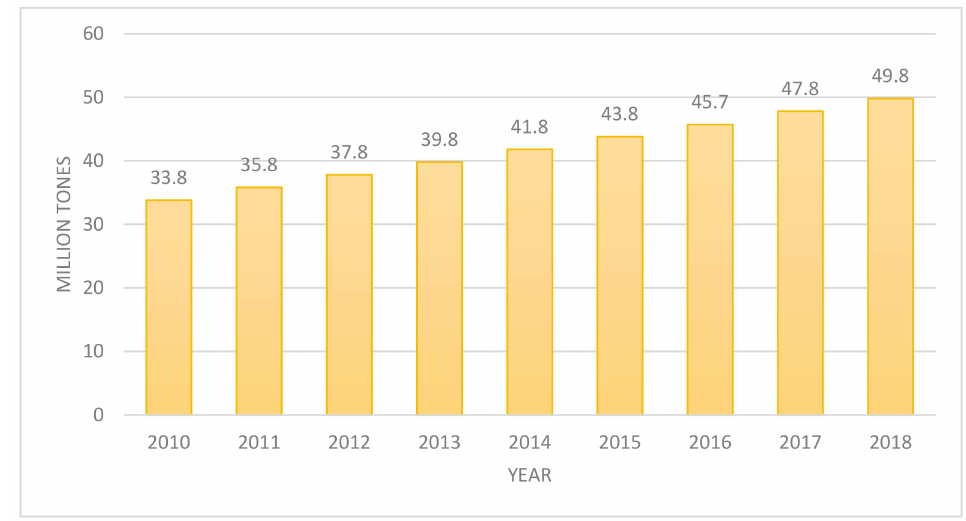
Figure 2. The trend of e-waste quantity produced in recent years